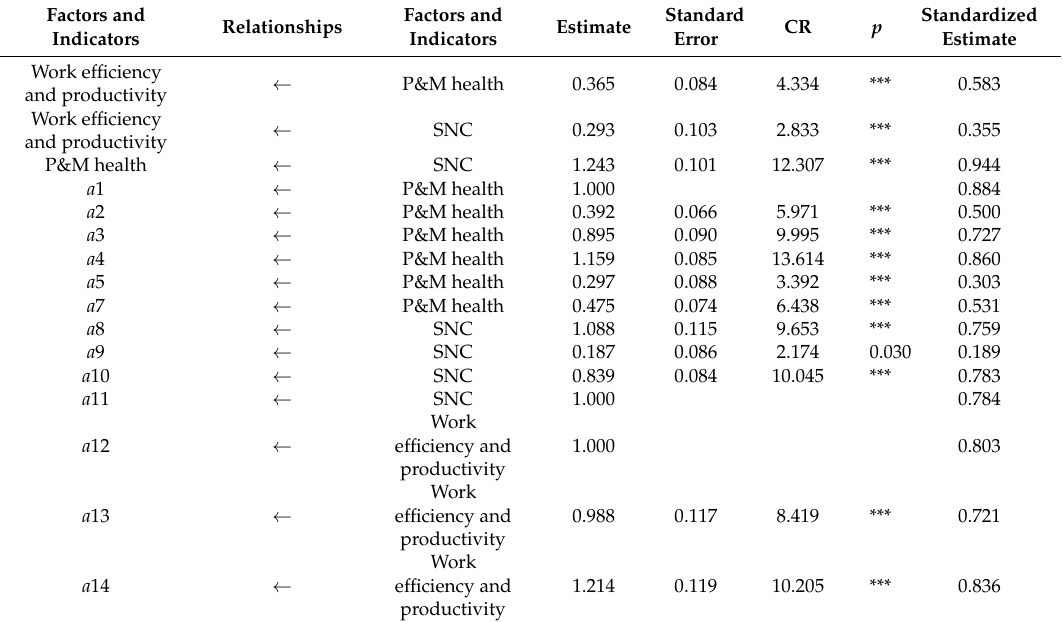
Table 5. Coefficient estimation of parameters in the initial model. CR, critical